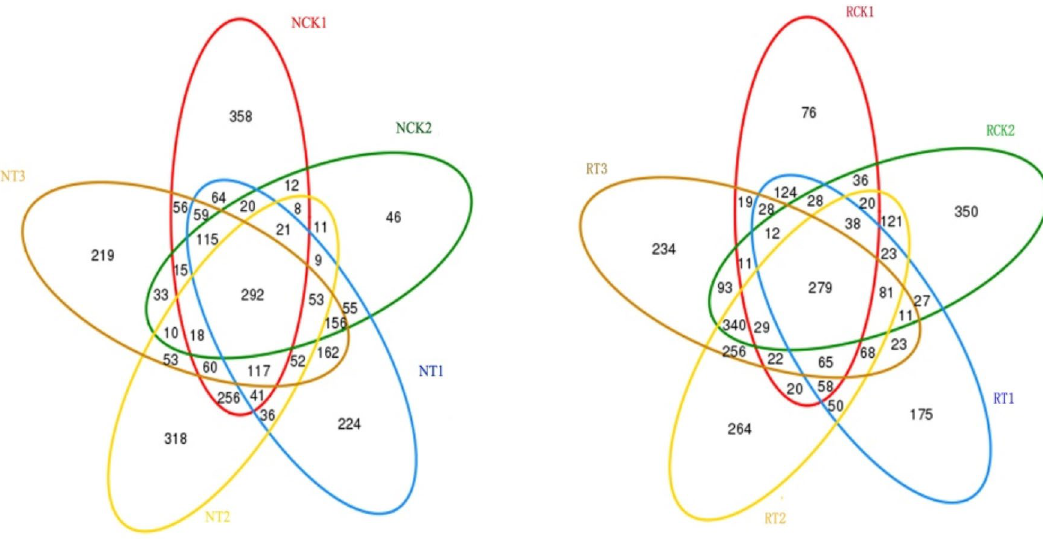
Figure 1. Venn diagrams showing the distribution of OTUs among different treatments. RCK1: R-soil in CK1; RCK2: R-soil in CK2; RT1: R-soil in T1; RT2: R-soil in T2; RT3: R-soil in T3; NCK1: N-soil in CK1; NCK2: N-soil in CK2; NT1: N-soil in T1; NT2: N-soil in T2; NT3: N-soil in T3.